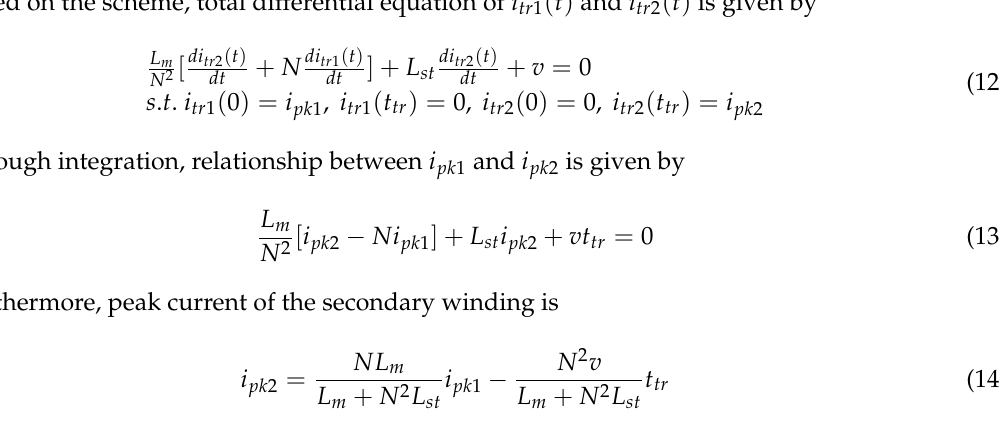
Figure 8. Flyback converter in transform state. ( a ) Active circuit, ( b ) Equivalent circuit scheme. Based on the scheme, total differential equation of i tr 1 ( t ) and i tr 2 ( t ) is given